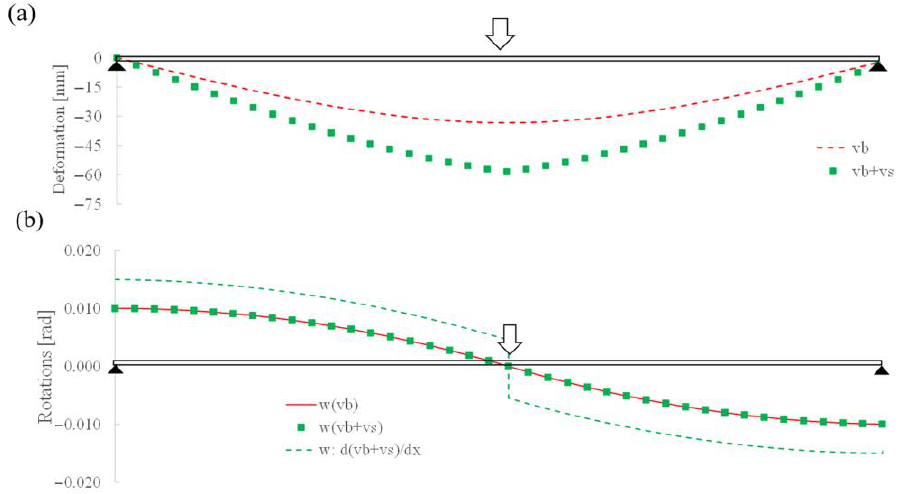
Figure 3. Example 1: ( a ) vertical deflections and ( b )